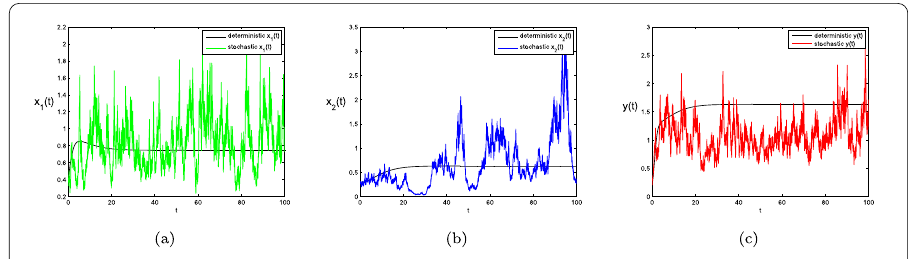
Figure 2 Solutions of stochastic system (3.1) with parameter values as mentioned in the text and σ 1 = 0.5, σ 2 = 0.4, σ 3 = 0.4, which show that all species persist. ( a ) The solution of x 1 ( t ); ( b ) the solution of x 2 ( t ); ( c ) the solution of y ( t )